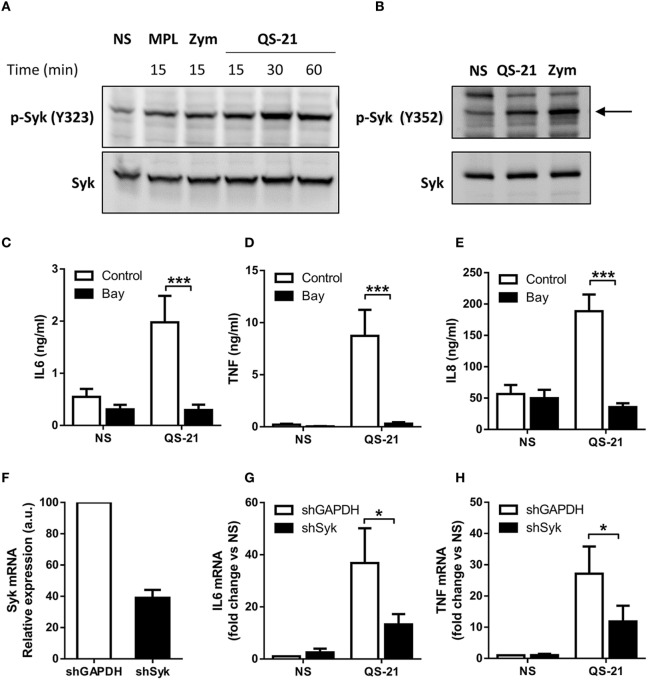
Syk activation and signaling is indispensable for response to QS-21 in moDCs. (A,B) Immunoblot analysis of cytoplasmic extracts of moDCs stimulated with QS-21, MPL, or Zymosan (Zym) for the indicated durations. Blots were probed sequentially with pY323-SYK (A) or pY352-SYK (B), followed by total Syk. (C–E) moDCs were treated with Bay 61-3606 (10 µM) for 1 h and stimulated with QS-21 (10 µg/ml) for 24 h. IL-6 (C), TNF (D), and IL-8 (E) were quantified in the supernatant by ELISA. Statistical significance was determined by a Wilcoxon matched-pairs signed-rank test. (F–H) moDCs were transduced with lentiviruses coding for shRNAs targeting GAPDH or Syk, and Syk (F), IL-6 (G), and TNF (H) mRNA expression were measured by qPCR and normalized against β-actin expression. Statistical significance was determined by a Wilcoxon matched-pairs signed-rank test. (I) moDCs were seeded on coverslips, treated with Bay 61-3606 (10 µM) for 1 h and stimulated with 10 µg/ml QS-21 for 2 h. NF-κB p65 was visualized by immunofluorescence and nuclear p65 was quantified using ImageJ software. Data are representative of three experiments. Statistical significance was determined with a non-parametric Mann–Whitney t-test.